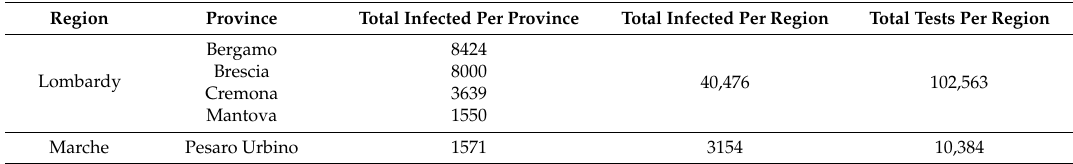
Table 1. Statistics of Coronavirus Disease-2019 (COVID-19) contagion in the selected provinces from